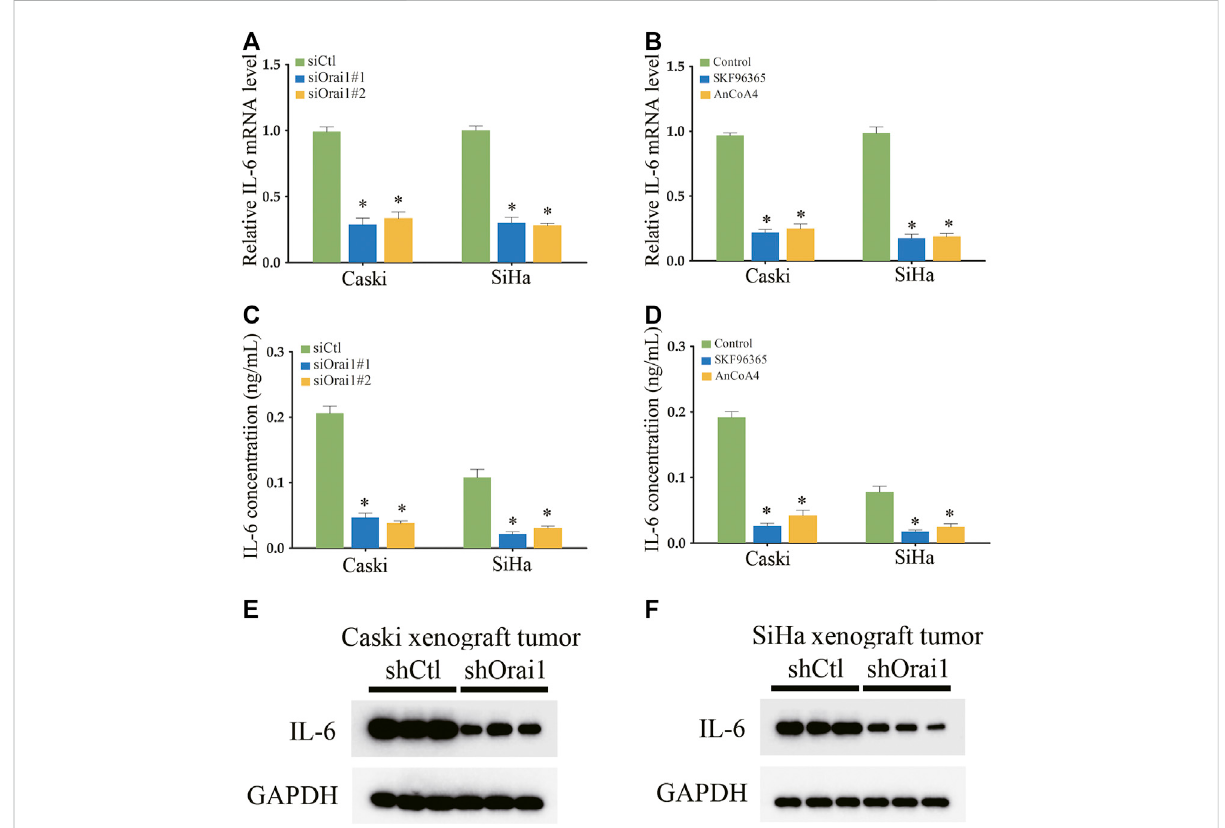
FIGURE 5 InhibitionofOrai1andSOCEreducedIL-6expressionincervicalcancercells (A – B) RelativeIL-6mRNAlevelsinCaskiandSiHacellstransfected with si-Orai1 or pre-treated with 10 μ MSKF96365 or 10 μ MAnCoA4. (C – D) IL-6 protein levels inthe supernatants from cells treatedas above. (E – F) Immunoblot showing IL-6 levels in xenografts derived from Caski and SiHa cells transfected with shCtl or shOrai1. Values are means ± SEM, * p < 0.05 compared to siCtl or control